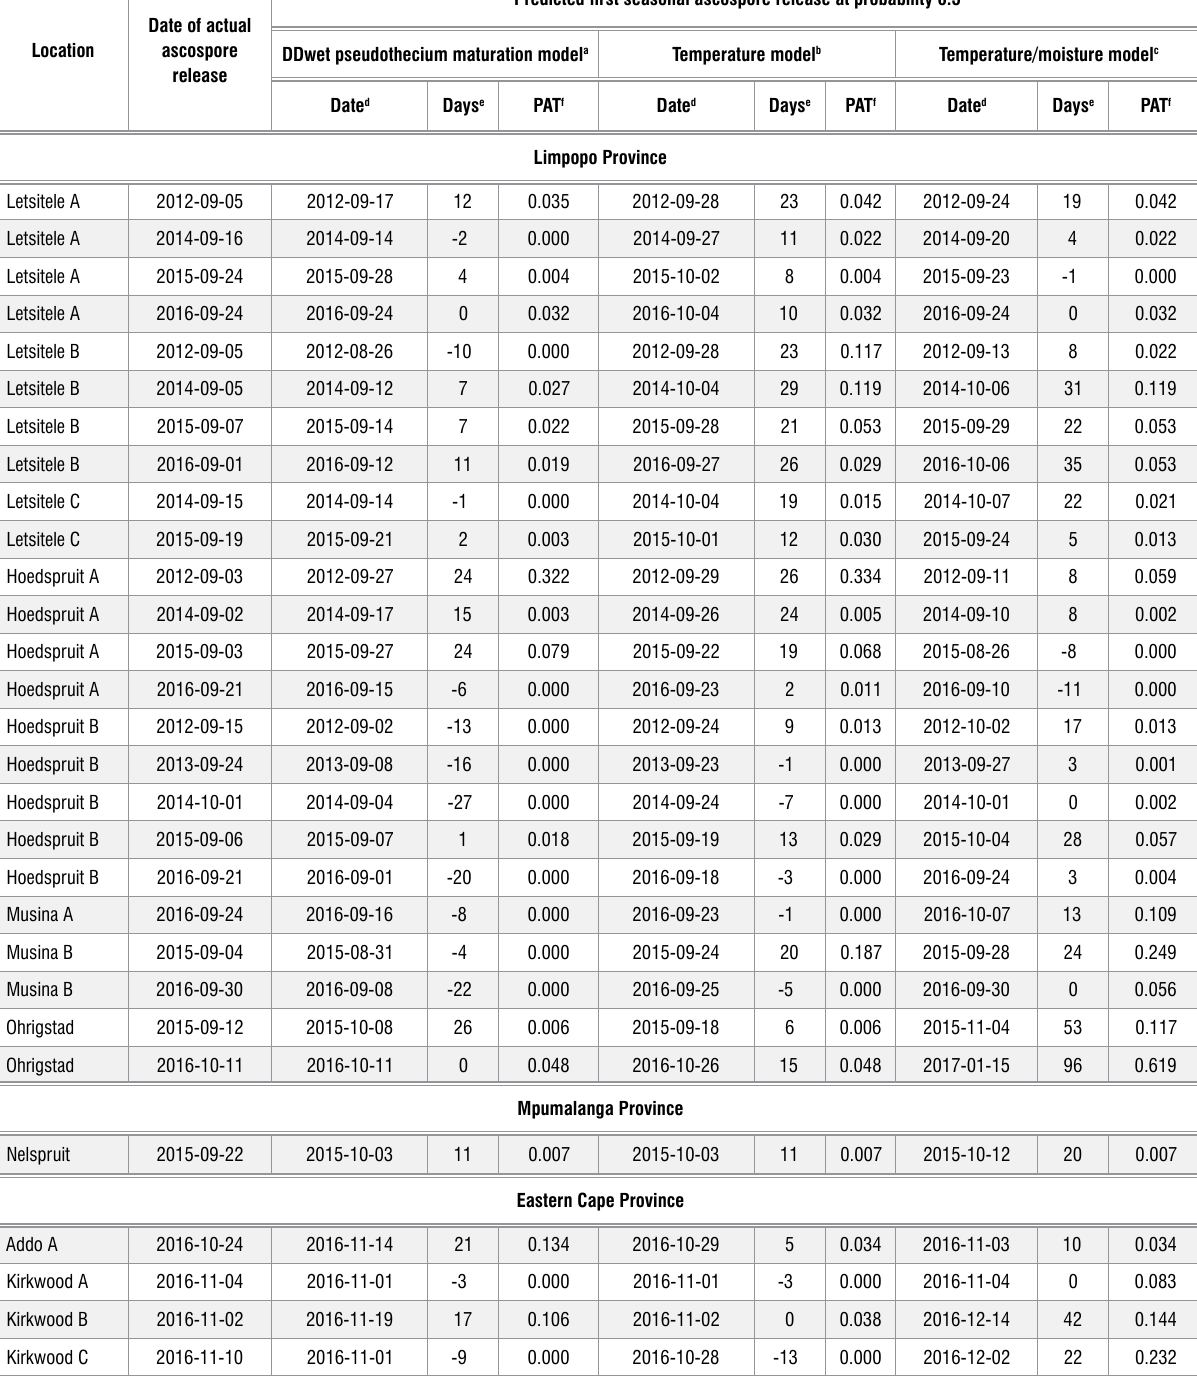
Table 7: Comparison of actual and predicted dates of first release of Phyllosticta ascospores as predicted by the DDwet pseudothecium maturation model, as well as the temperature and temperature/moisture pseudothecium models proposed by Fourie et al. 25 , in different South African citrus growing regions between 2012 and 2016